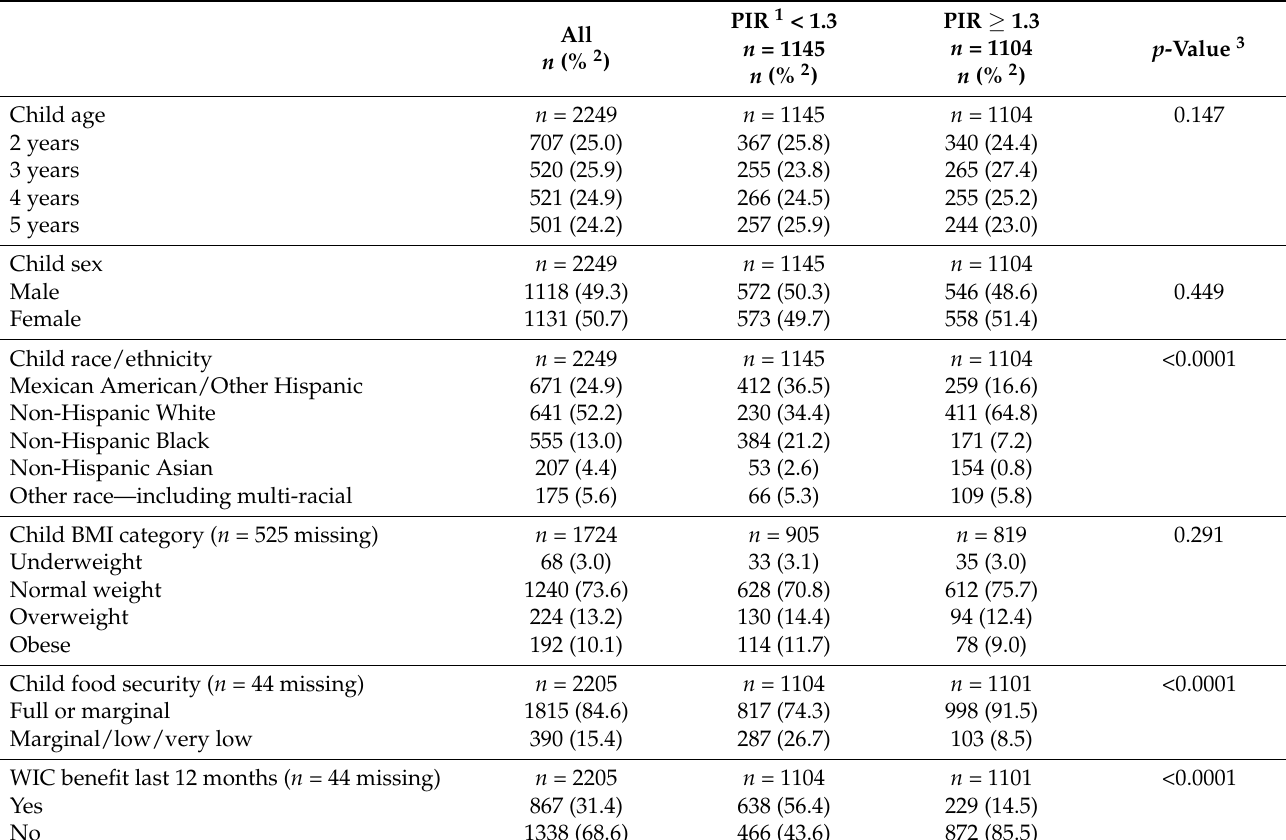
Table 1. Demographic characteristics of children 2–5 years (with 2 days reliable dietary intake data) and household reference persons, NHANES